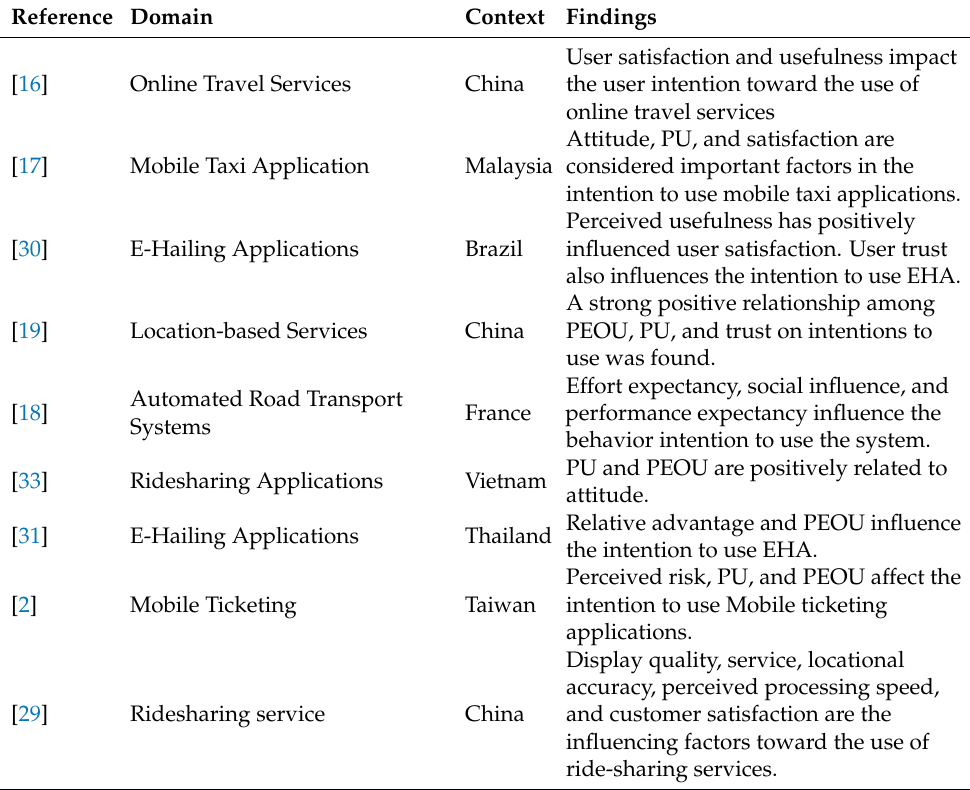
Table 4. Literature